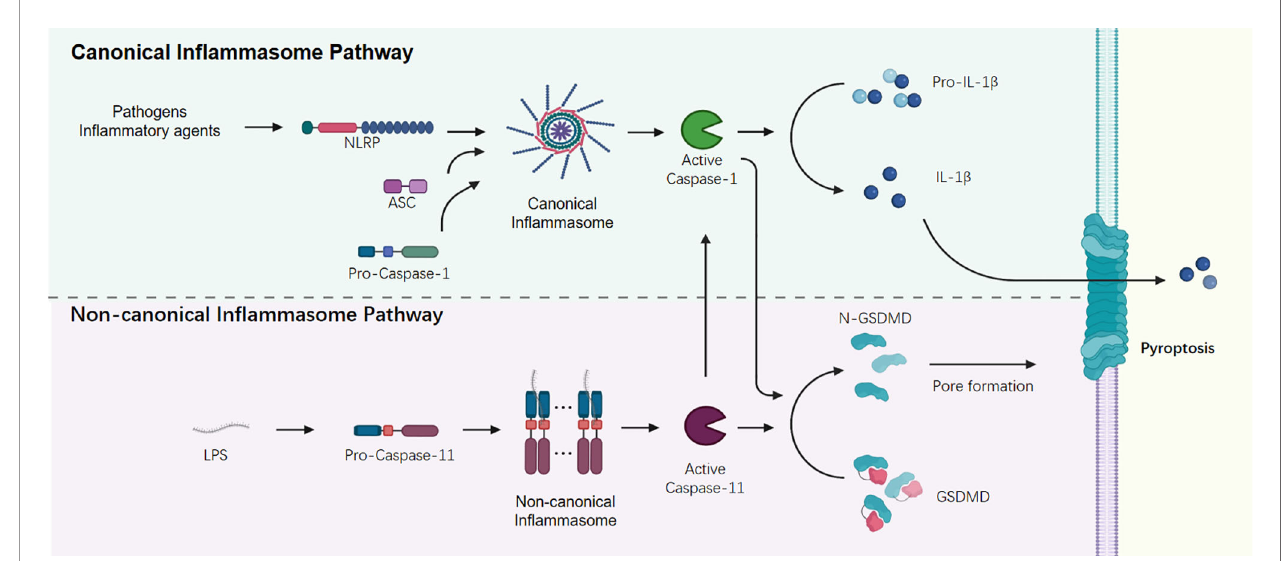
FIGURE 1 | Canonical and non-canonical In fl ammasome signaling